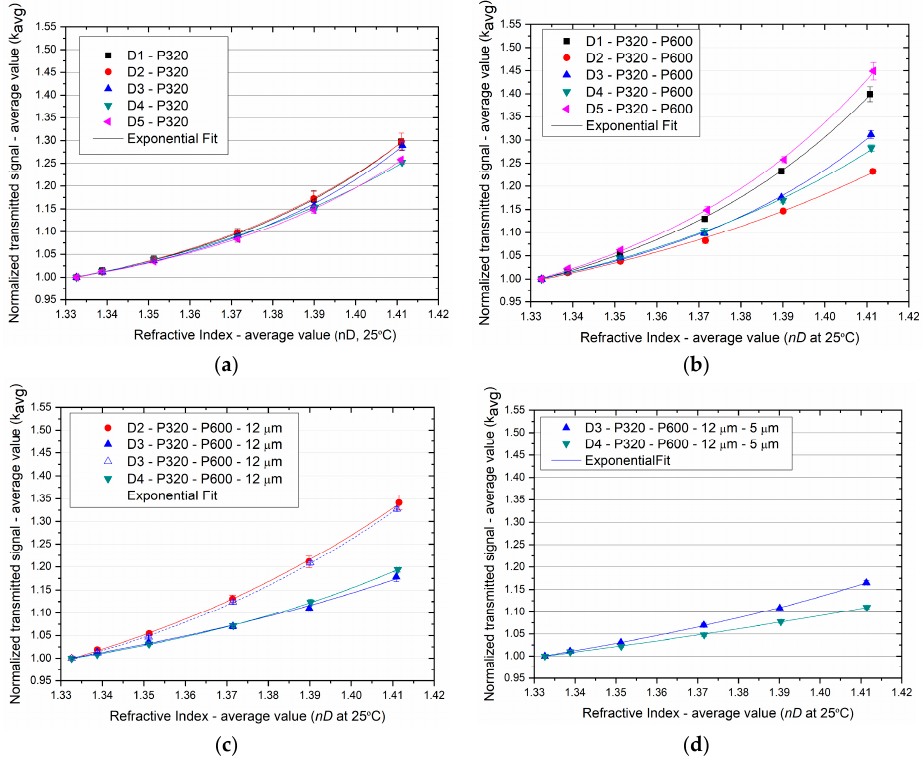
Figure 8. Variation of the normalized transmitted signal with increasing refractive index: ( a ) Polishing 1 (P320); ( b ) Polishing 2 (P600); ( c ) Polishing 3 (12 µm grit size); ( d ) Polishing 4 (5 µm grit size). Estimated grit size: P320 ~ 46 µm and P600 ~ 26 µm. Table 4. Obtained results from the RI characterizations and exponential fit.